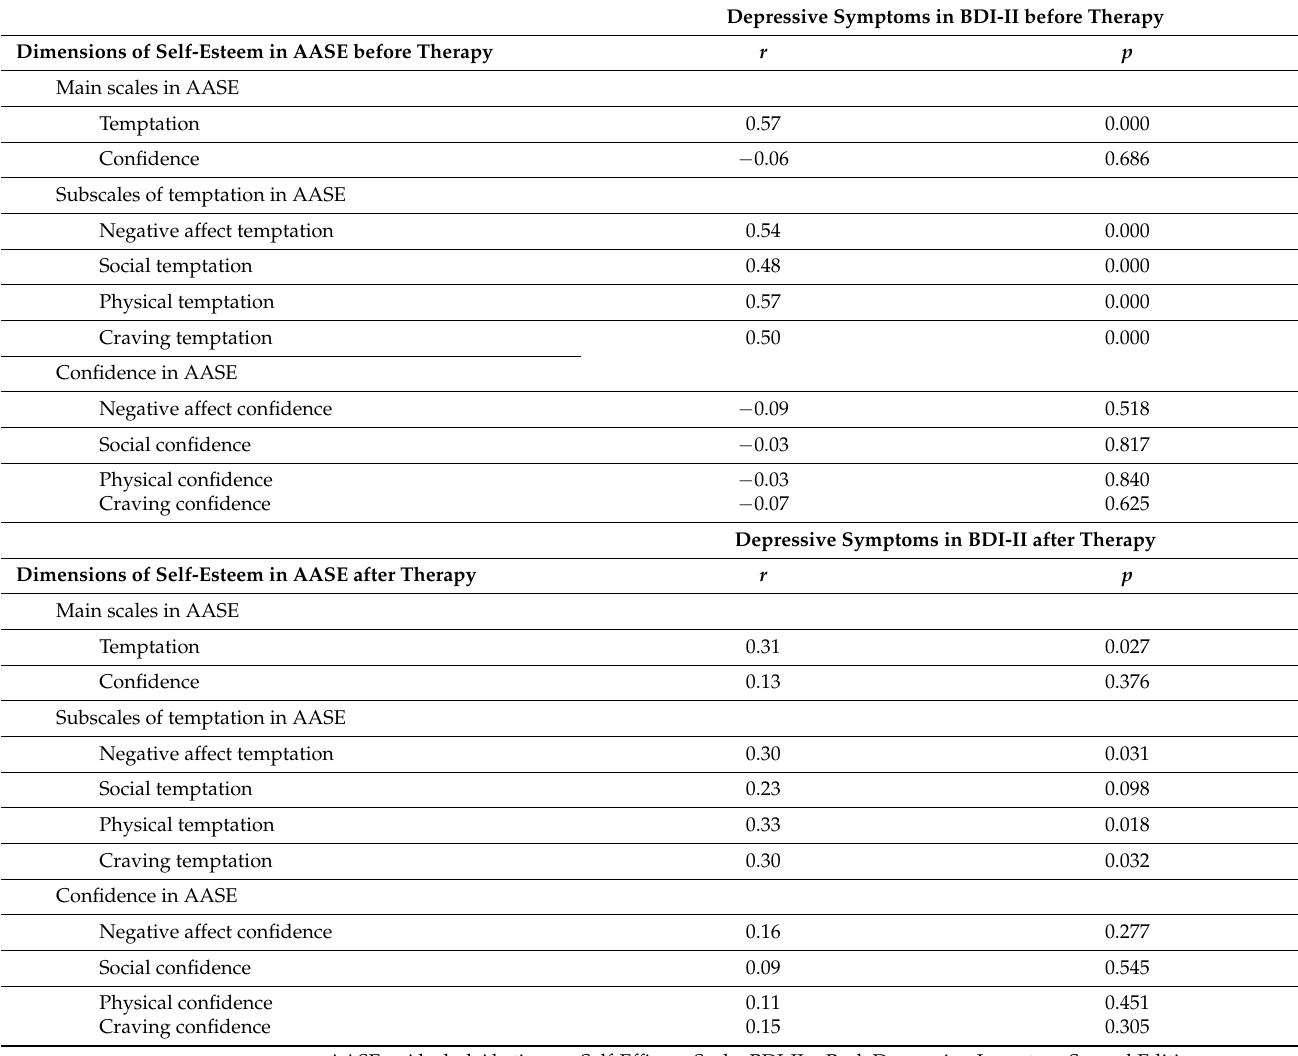
Table 6. Relationships between dimensions of self-efficacy and depressive symptoms in the investi- gated group before and after